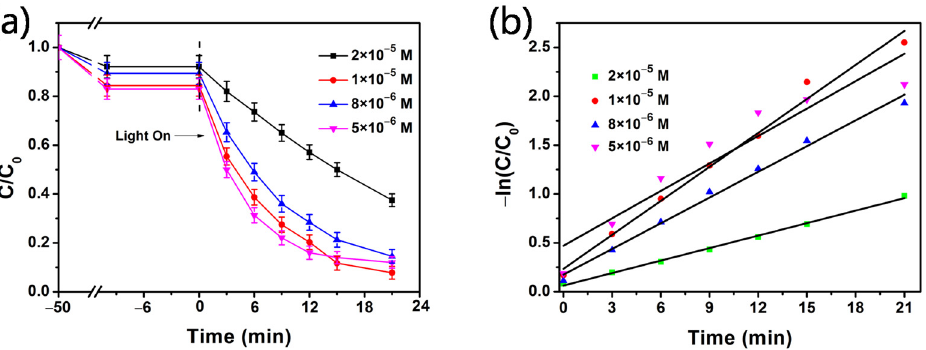
Figure 5. ( a ) Effect of MB initial concentrations on photocatalytic degradation. ( b ) Kinetic plots of − ln(C/C 0 ) versus time.